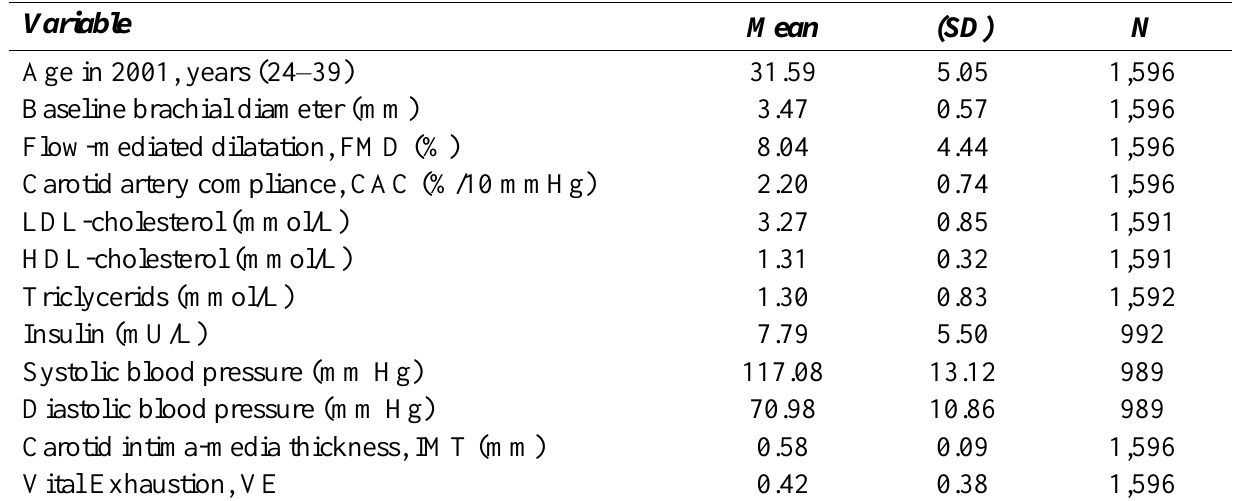
Table 1. Characteristics of study participants.